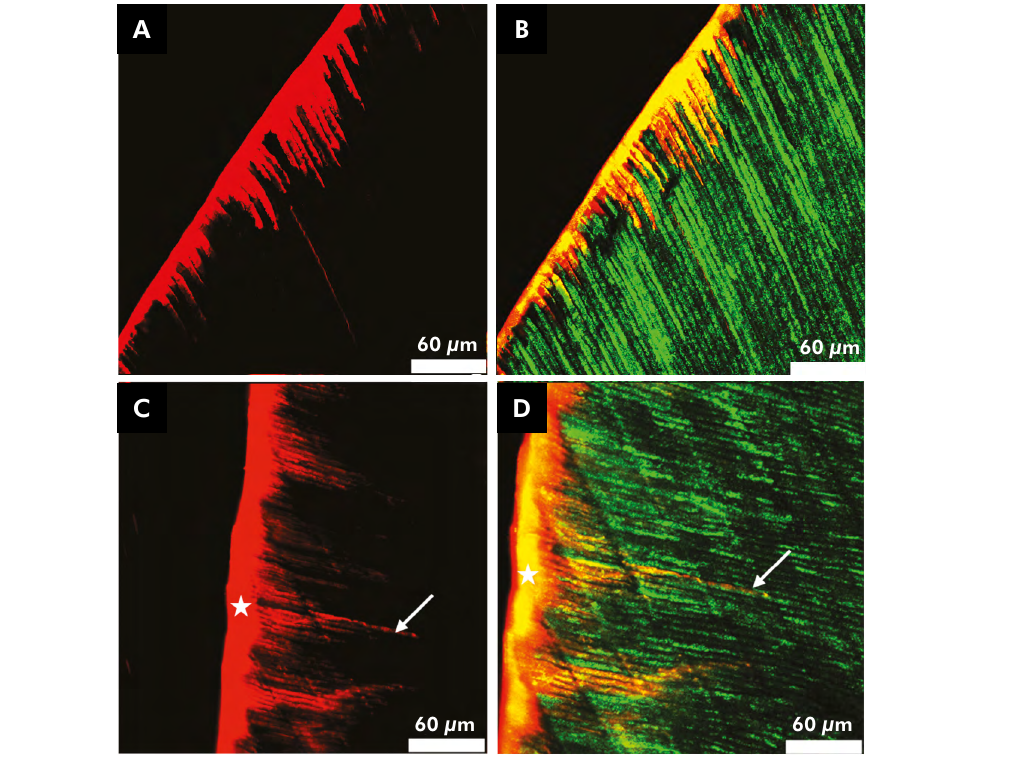
Figure 2. Representative images in dual fluorescence mode: infiltrated structures are in red (RITC), and porous structures are in green (NaFl). A. Icon at 25º C showed superficial penetration. B. Interaction between the infiltrant and the structures of the lesion body can be observed in yellow (25 ° C). C, D. Icon, at 55º C presented longer tags (white narrow), but a thick layer of material on the surface was observed, evidencing its retention on the surface of the lesion (white